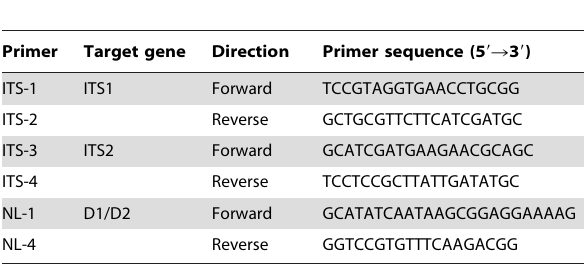
Table 1. Fungus-specific universal primers used for PCR amplification of rRNA